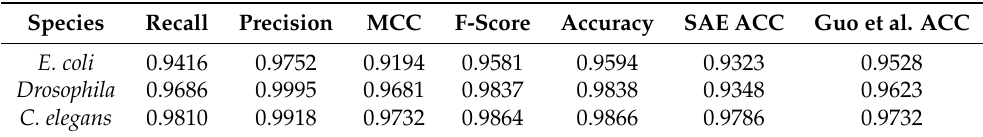
Table 10. Performance comparisons on datasets for other